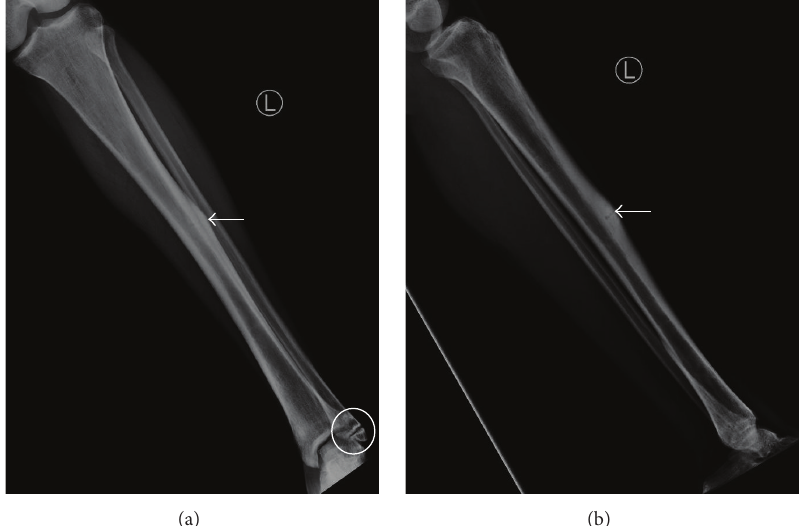
Figure 9: Young adult male with history of Rothmund-Thomson syndrome diagnosed at 2 years of age. Findings: (a) increased cortical thickening of the lateral mid tibia diaphysis when compared to prior radiographs from 8 years earlier (arrow). A chronic appearing ununited lateral malleolus fracture is also present (circle). (b) An increase in anterior cortical thickening of the mid tibia diaphysis has also occurred with a subtle fracture line through the anterior tibial cortex at the site of cortical thickening (arrow). Technique: (a) AP radiograph kVp = 63, mAs = 3, and (b) lateral radiograph kVp = 63, mAs = 3.